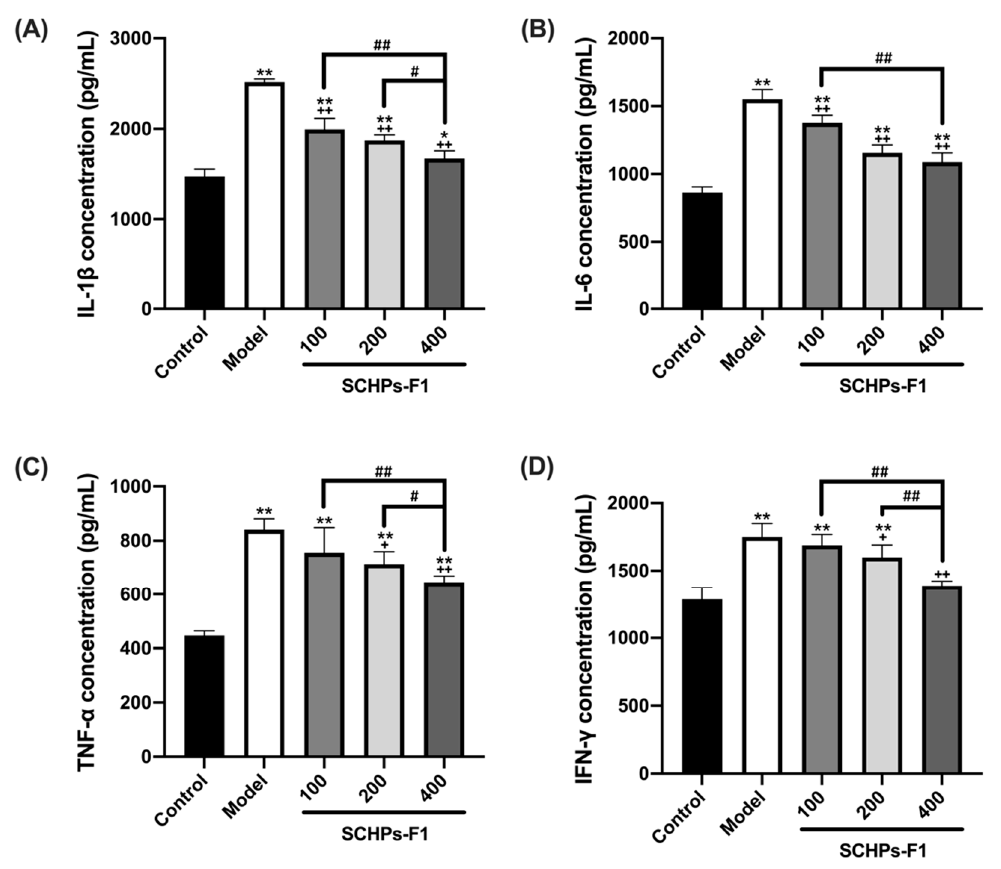
Figure 4. Effects of SCHPs-F1 on inflammatory cytokines levels of IL-1 β ( A ), IL-6 ( B ), TNF- α ( C ), and IFN- γ ( D ) in CTX-exposed kidney tissues. * P < 0.05, ** P < 0.01, vs. control group; + P < 0.05, ++ P < 0.01, vs. model group; # P < 0.05, ## P < 0.01 indicate significant differences between different SCHPs- SCHPs-F1 dose F1 dose groups.